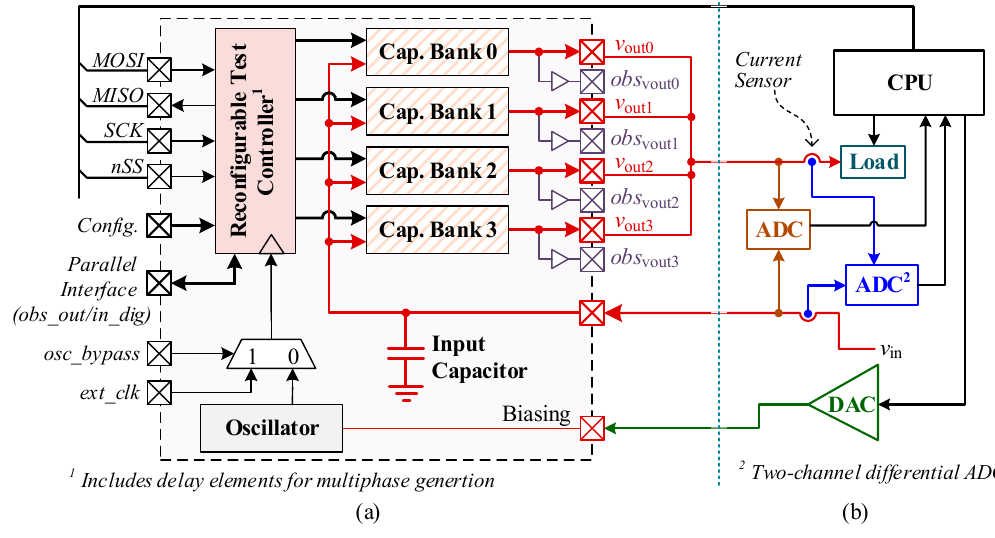
Figure 5. ( a ) Test chip implementation block diagram; ( b ) off-chip components for testing.